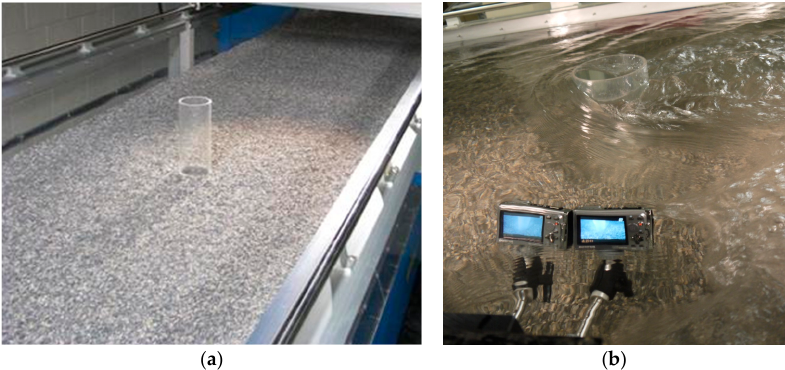
Figure 1. ( a ) View of the hydraulic flume; ( b ) View of the cameras recording the bed during the experiment.